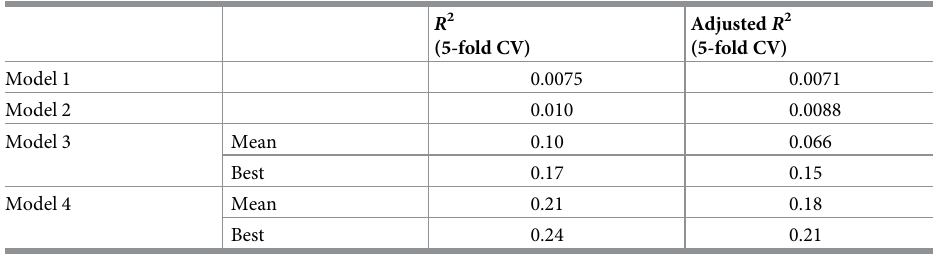
Table 7. Comparison of regression performance among four